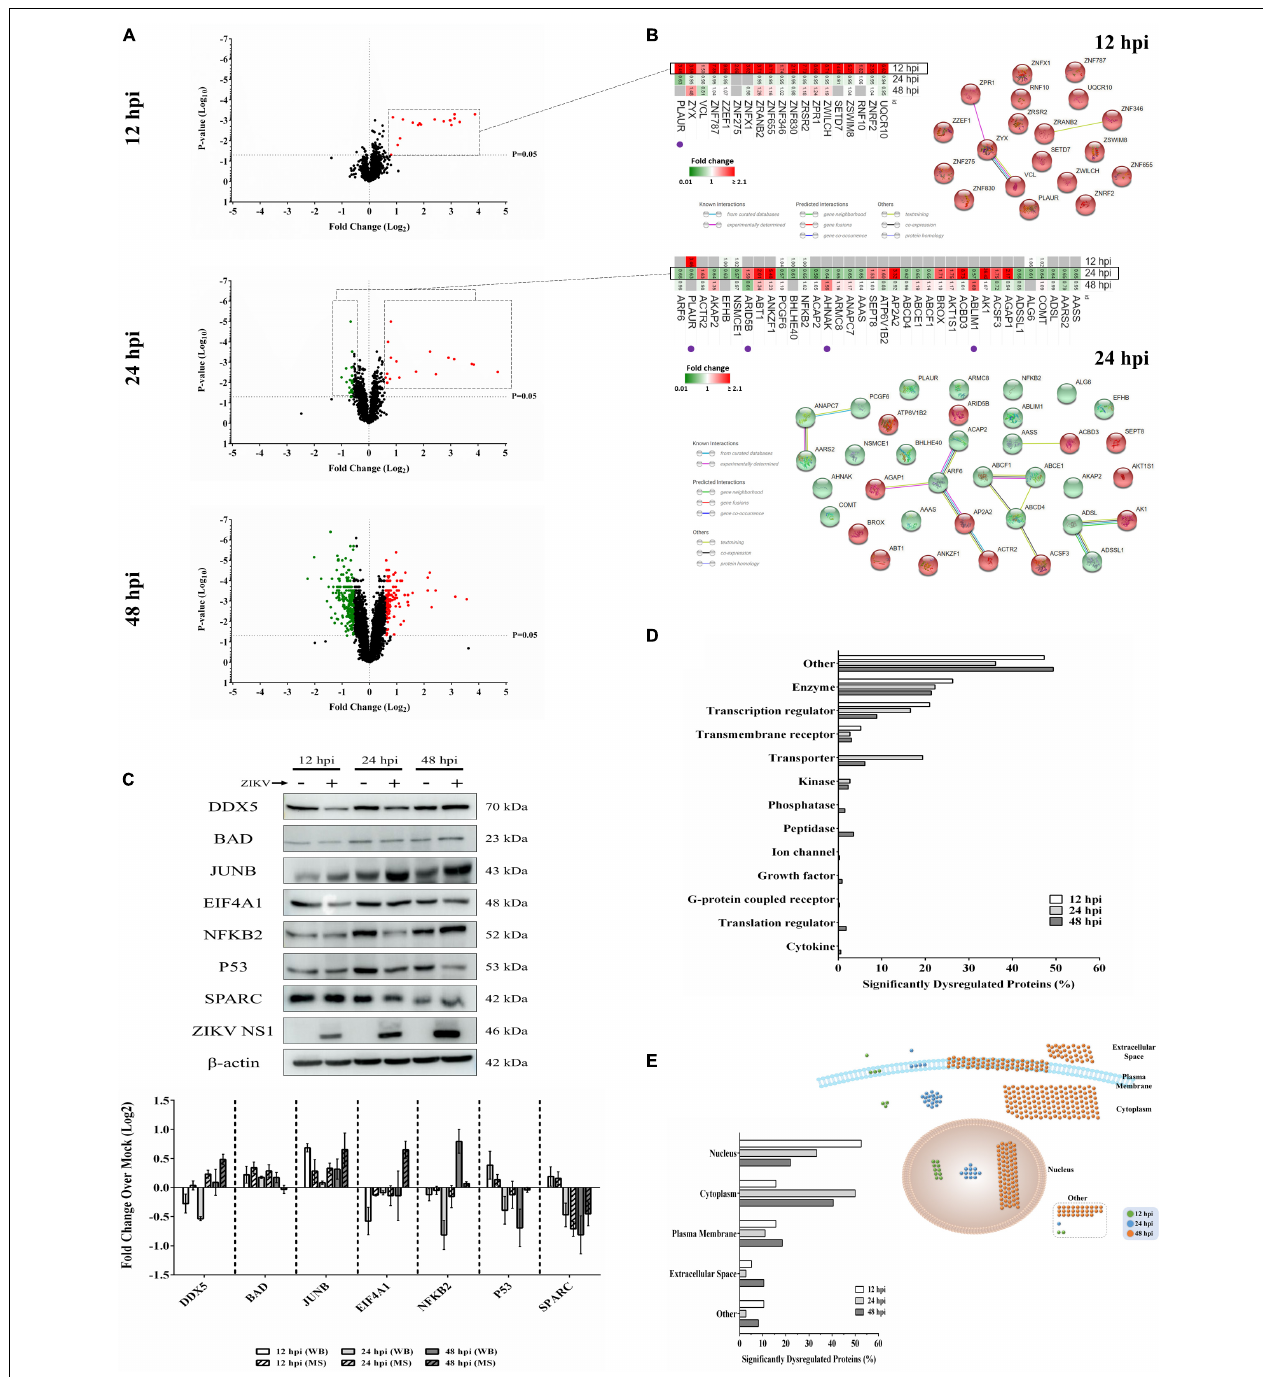
FIGURE 1 | Mass spectrometry proteomic analysis of ZIKV-infected Vero cells. (A) Volcano plots displaying ZIKV-induced log 2 –fold protein level changes and significance of differentially regulated proteins at 12 (upper panel), 24 (middle panel), and 48 (lower panel) hours post-infection (hpi) ( p -value < 0.05). (B) The quantitative comparison heatmaps indicating fold changes and protein-protein interaction networks of differentially dysregulated proteins across two time points (12 and 24 hpi). The protein-protein interaction network of the large number of differentially dysregulated proteins at 48 hpi is shown in Supplementary Figure S1 . Proteins labeled with purple dots below heatmaps were significantly differentially expressed in the opposite direction at either earlier or later time points. (C) Western blot validation of selected differentially dysregulated proteins from mass spectrometry results. Representative blots are shown. Different loading controls were used for the densitometry normalization and analysis. Protein fold changes and availability of antibodies were taken into account for validation. ZIKV NS1 was probed to confirm the infection. (D) Classification of significantly dysregulated protein type at different time points after ZIKV infection. (E) The subcellular localizations of dysregulated proteins at different time points represented both quantitatively (left panel) and graphically (right panel).